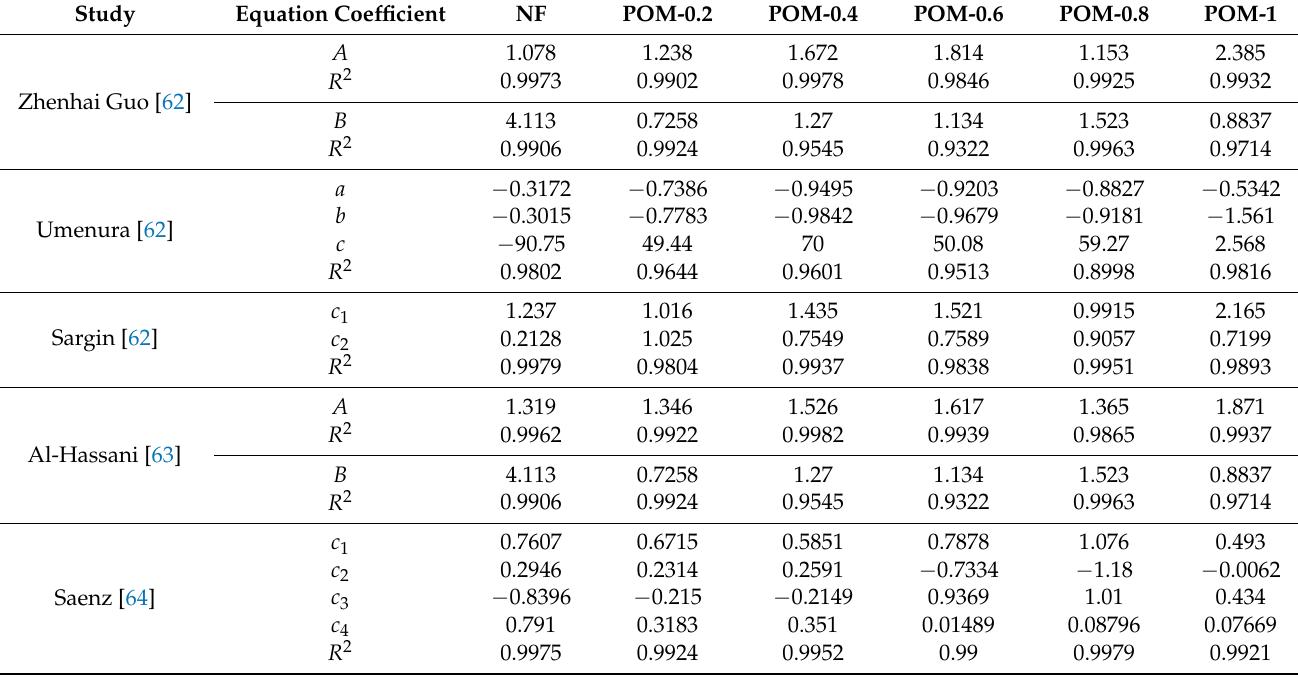
Table 13. Fitting results of